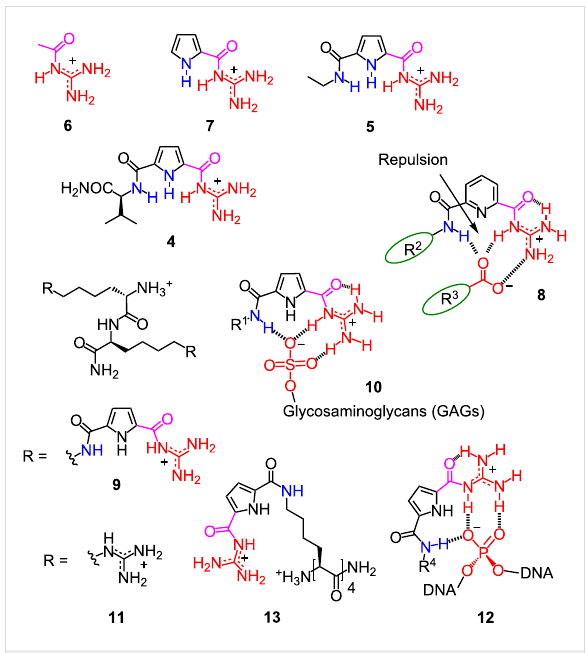
Figure 2: From Schmuck cations to cell-penetrating dipeptides, with schematic representation of the binding model between GCPs and GAGs on the cell surface, and with